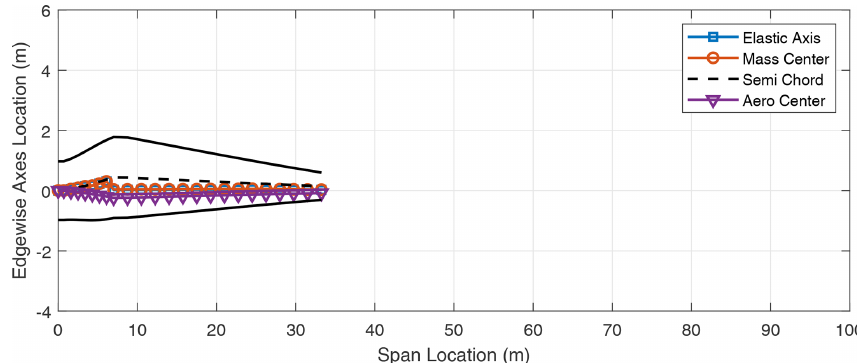
Figure A1. Planform for the WindPACT 1.5MW turbine blade.